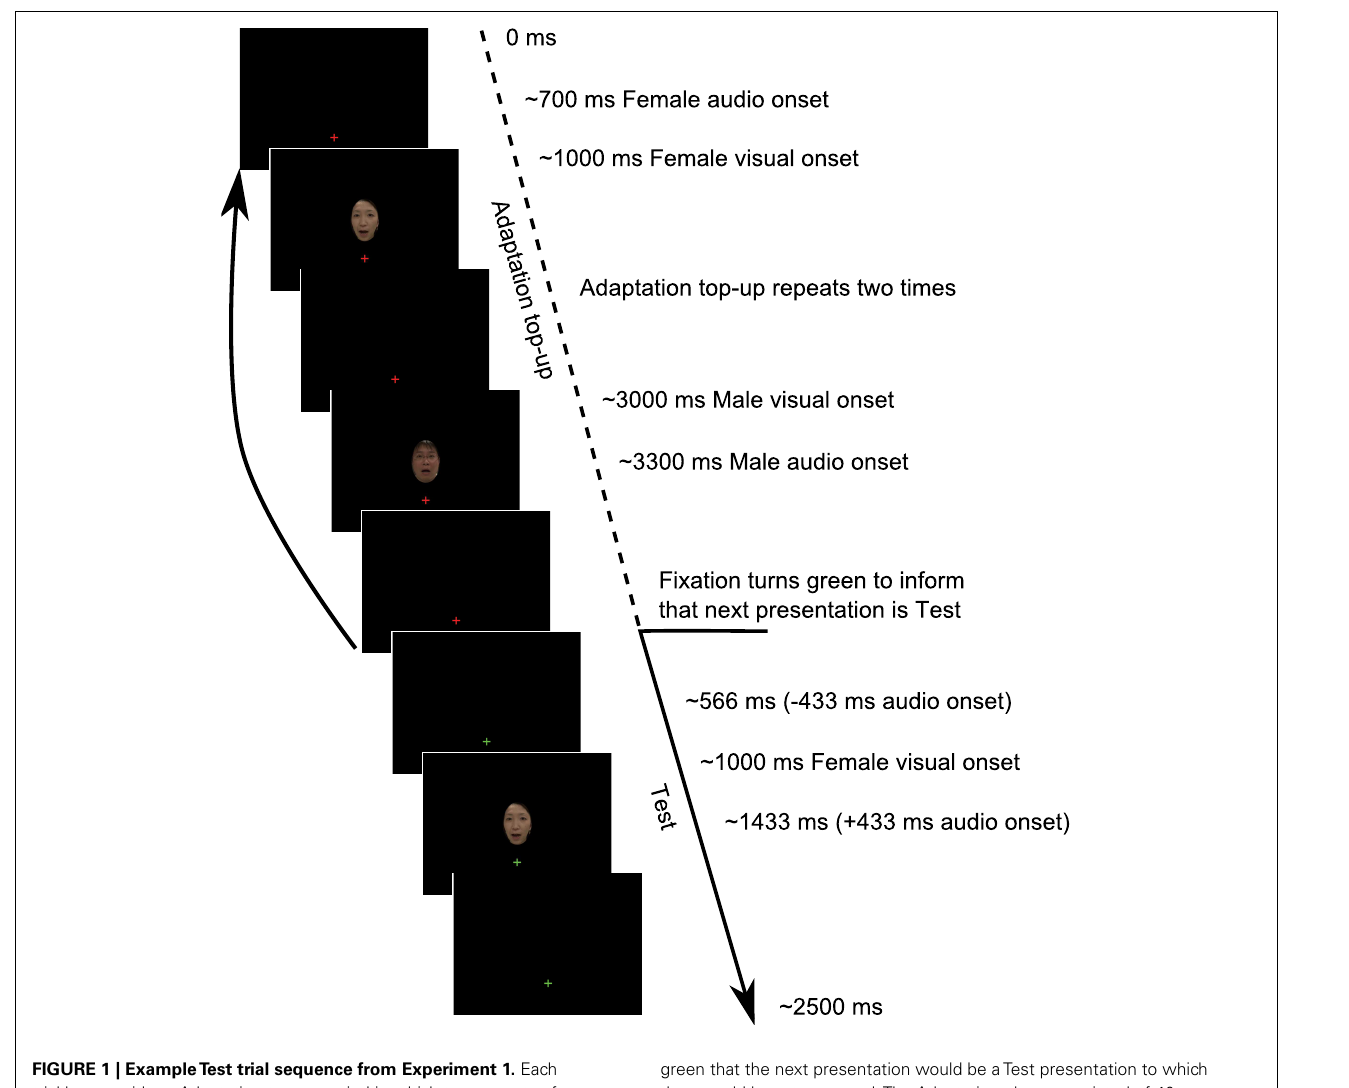
FIGURE 1 | ExampleTest trial sequence from Experiment 1. Each trial began with an Adaptation top-up period in which two repeats of each of the adapting relationships from the previously presented Adaptation phase were repeated. Following the top-up period, participants were informed by a change in the fixation cross from red to